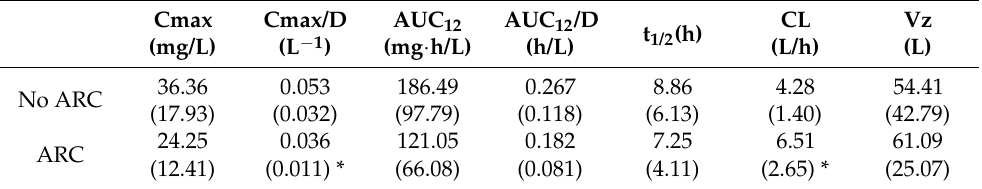
Figure 1. Spaghetti plots for plasma levetiracetam concentration-time profiles, according to dose received by each subject. In black, lines represent profiles after dose of 500 mg, blue lines, 1000 mg and red lines, 1500 mg. Dashed lines represent the target concentration values (6 mg/L, 12 mg/L or 46 mg/L). Table 2. Levetiracetam pharmacokinetic parameters (mean and standard deviation) at steady state following intravenous administration of 500–1500 mg every 12 h to critically ill patients.